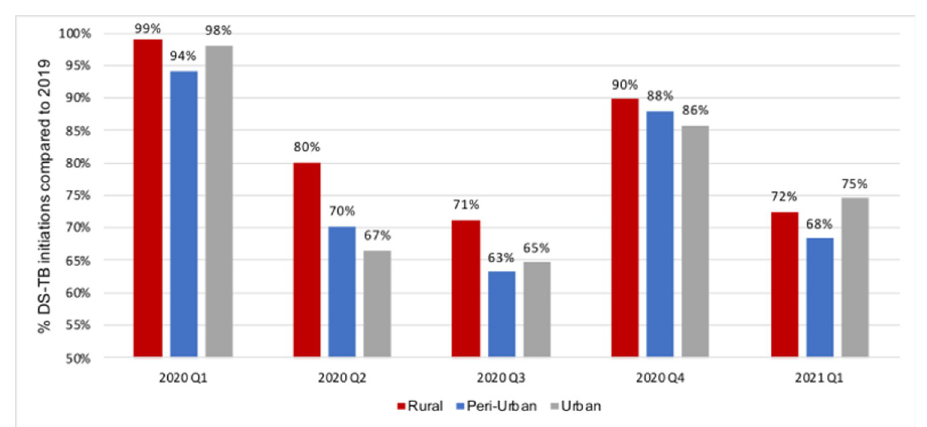
Fig 4. TB treatment initiations as proportion of initiations in same quarter of 2019, by setting.